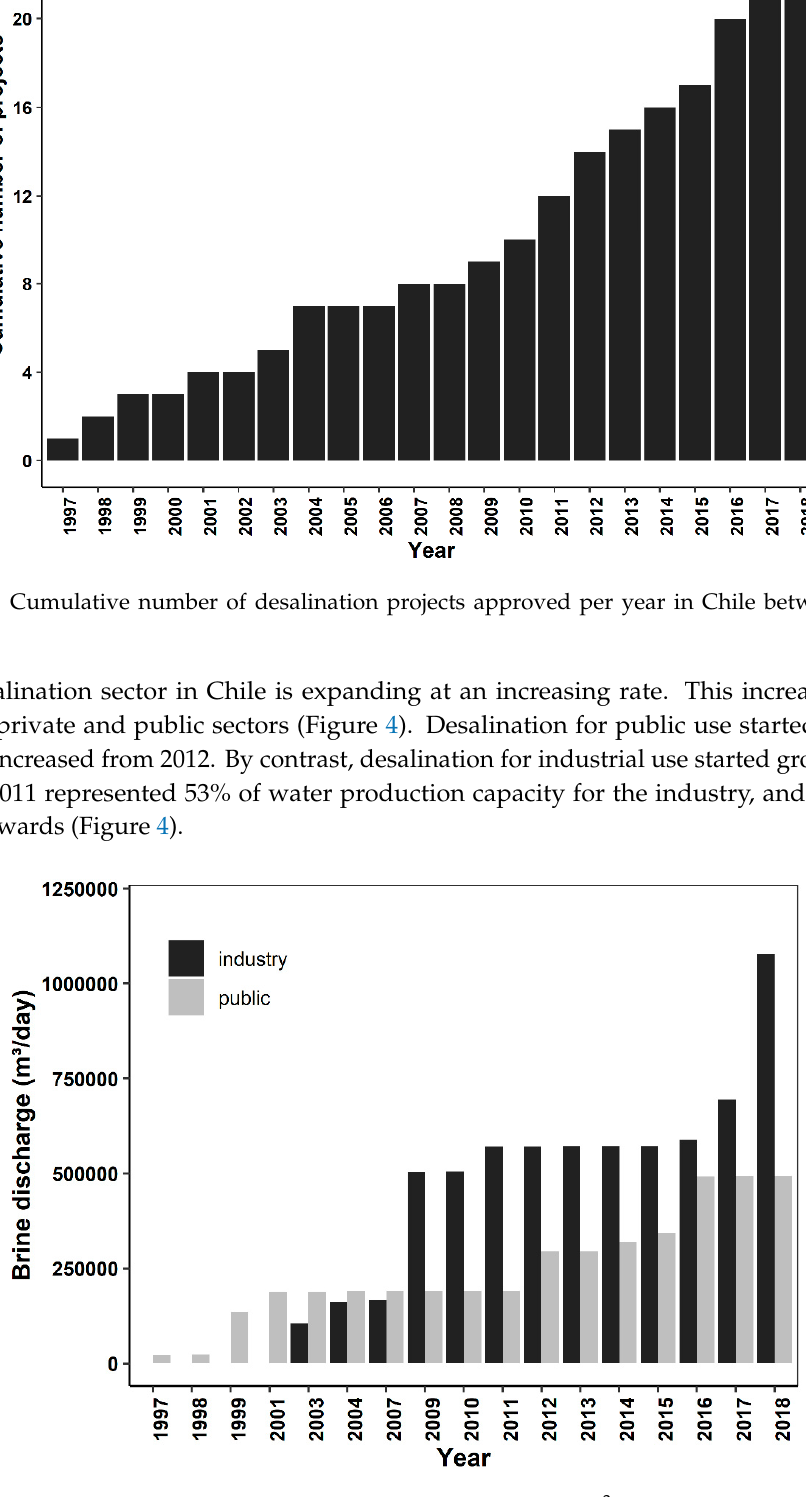
Figure 4. Assessment of the accumulated brine discharge production (m 3 / day) in the Chilean industrial and public sectors.